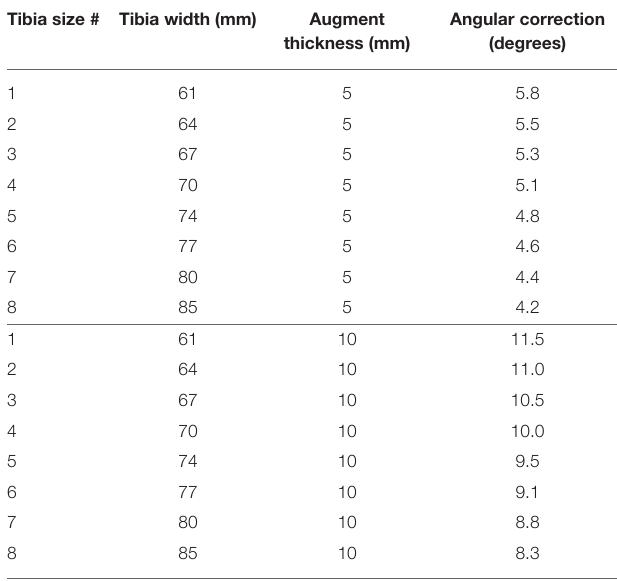
TABLE 3 | Encountered problems specific to mechanically aligned primary arthroplasties revised with the rKA protocol and their